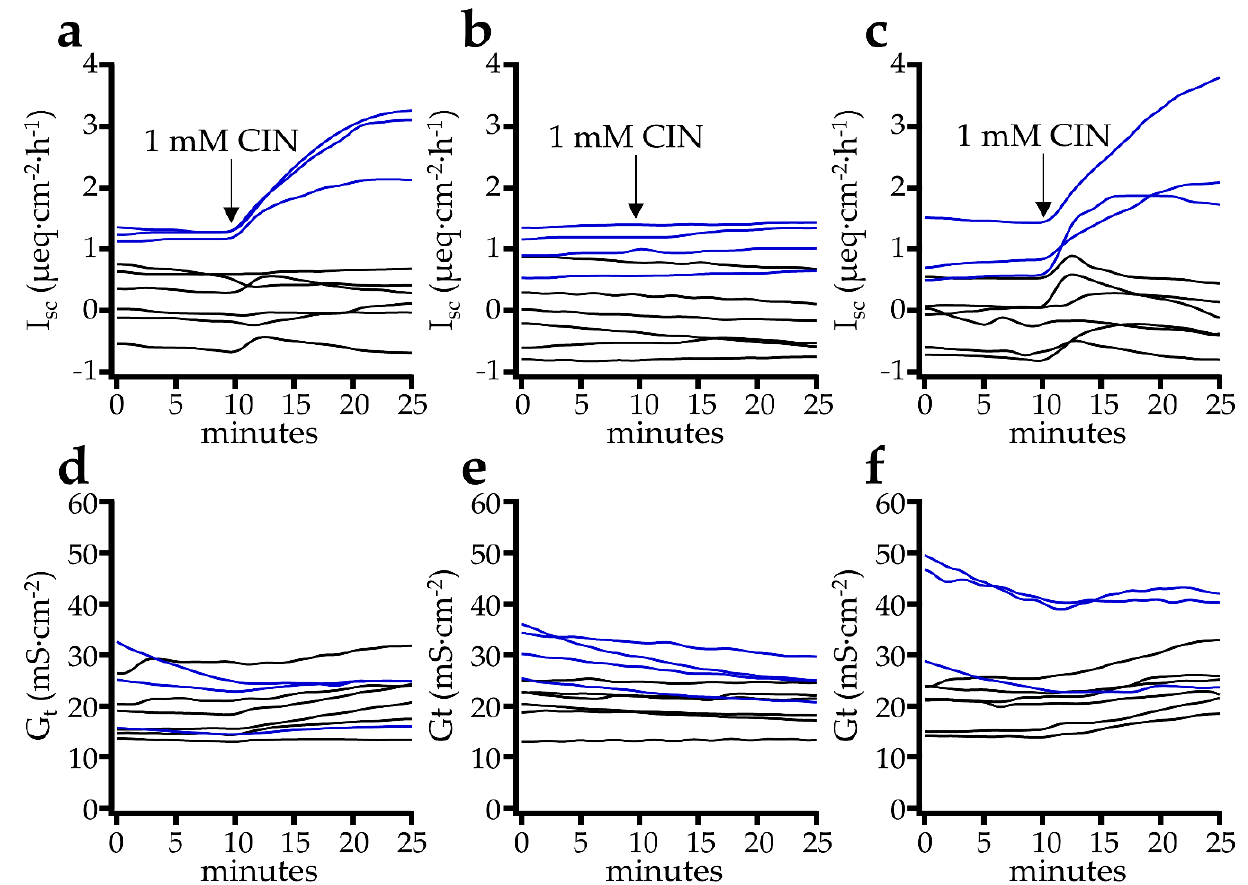
Figure 3. Effect of the TRPA1 agonist cinnamaldehyde (CIN) at a concentration of 1 mmol·L − 1 after the mucosal ( a , d ), serosal ( b , e ) or bilateral addition ( c , f ) to I sc and G t in the Ussing chamber using the colonic tissue of pigs. After mucosal and bilateral addition, a significant increase in I sc and G t was observed, although the effects were absent after the serosal addition (details see text). In this figure, some tissues were obtained from older, larger pigs from a commercial slaughterhouse (blue lines), which showed a strong, sustained increase, while the black lines reflect the frequently biphasic responses that were seen in younger and smaller pigs slaughtered within a controlled study, as in the rest of the manuscript.